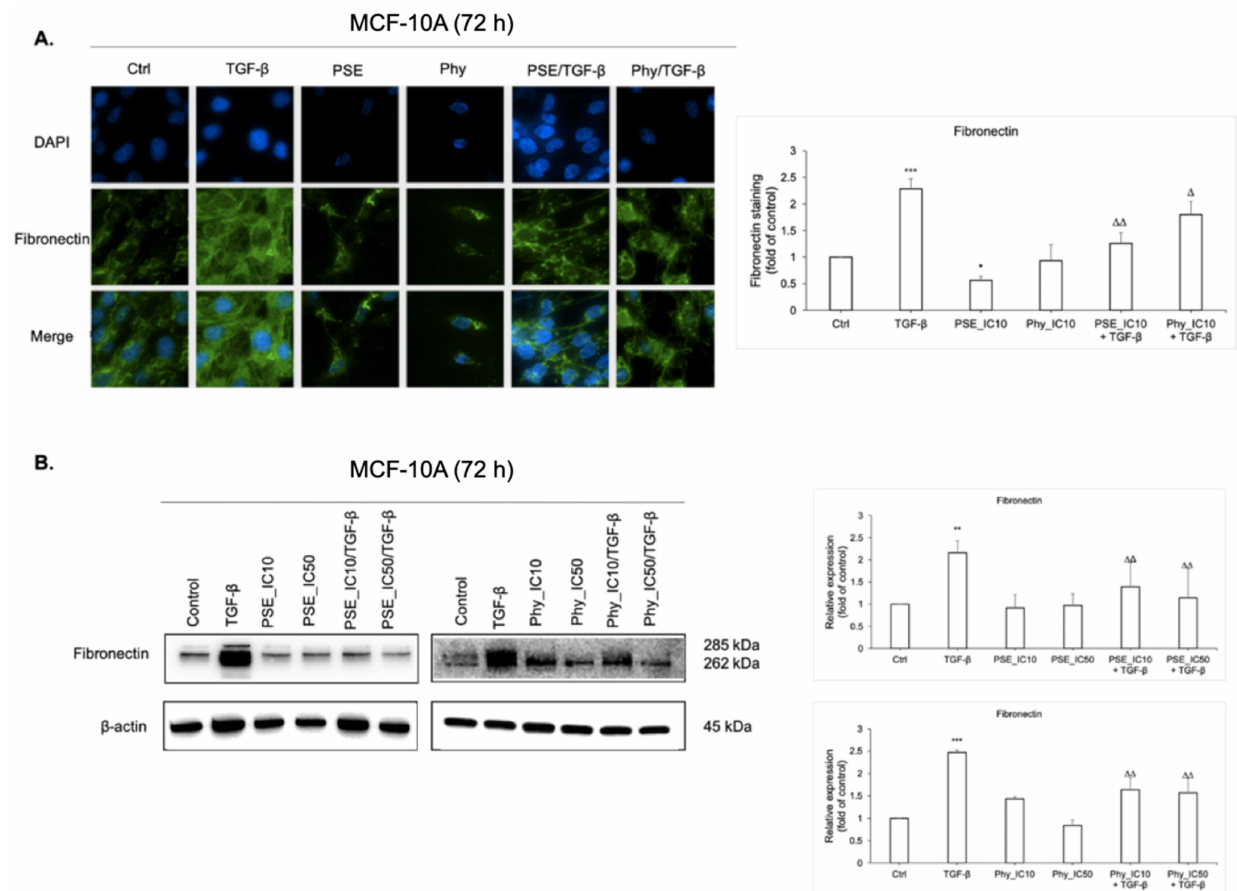
Figure 8. PSE and Phy reduced expression of fibronectin. ( A ) Immunofluorescence detection of fibronectin in MCF-10A cells. The green signal represents corresponding protein staining by Alexa Fluor 488 and the blue signal indicates nuclei staining by DAPI. Original magnification x200. The fluorescence staining of fibronectin was analysed using ImageJ software. Quantification is relative to the control. The protein levels of mesenchymal marker fibronectin were assayed by Western blot analysis ( B ) using IC 10 and IC 50 concentrations of PSE and Phy. The band intensities of target protein were measured using the Image Studio Lite software. Quantification is relative to the control and normalised to β -actin expression. Data in graphs are shown as mean ± SD for three separate experiments. * p < 0.05, ** p < 0.01, *** p < 0.001 compared to control; ∆ p < 0.05, ∆∆ p < 0.01 compared to TGF- β